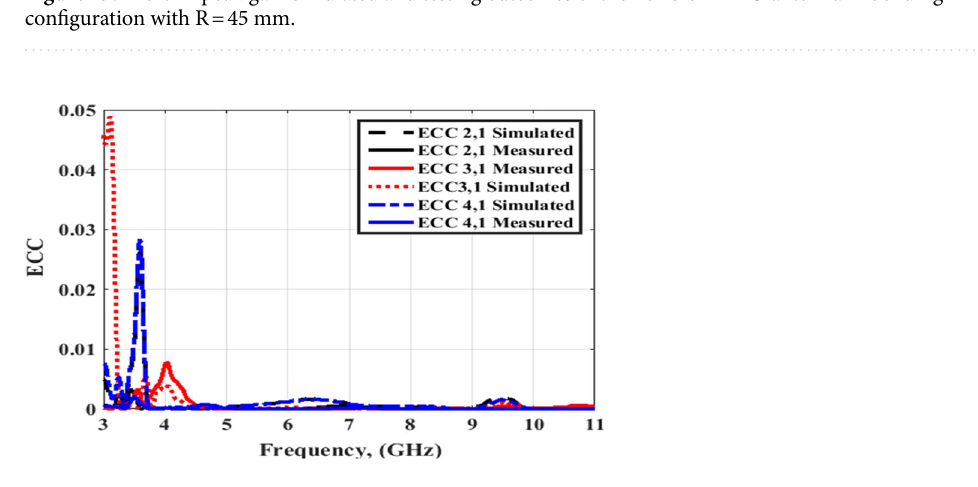
Figure 20. Port #1 ECC simulated and testing outcomes of the flexible MIMO antenna in the flat configuration.